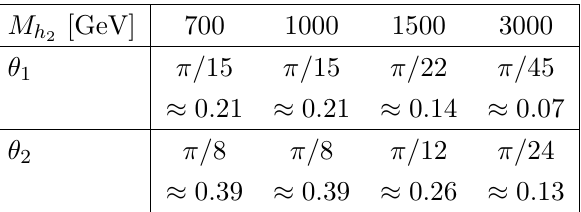
(cid:18) 1 and 2 are given for all considered benchmark points, which are also = 125 GeV and (cid:22) 1 = (cid:21) 1 = (cid:21) 2 = 0. 1